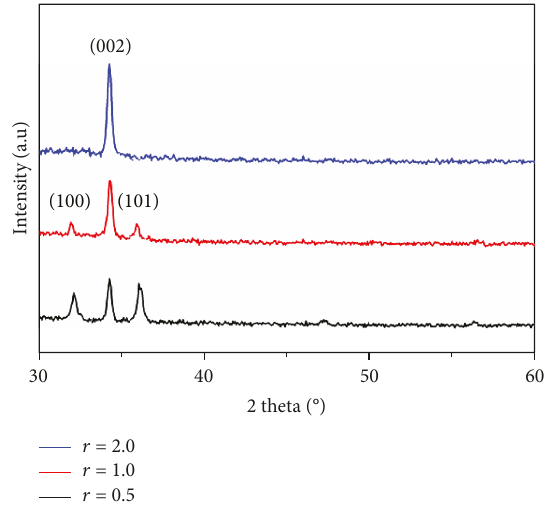
Figure 5: XRD patterns of ZnO thin fi lms prepared at di ff erent stabilizer molar ratios.